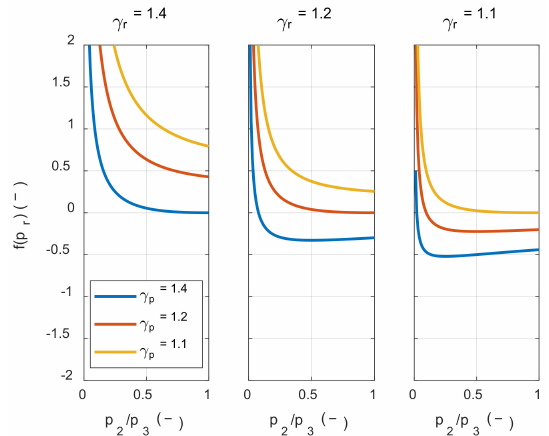
Figure 4. The e ff ect of the pressure ratio and the specific heat ratio on the net work sensitivity of the initial